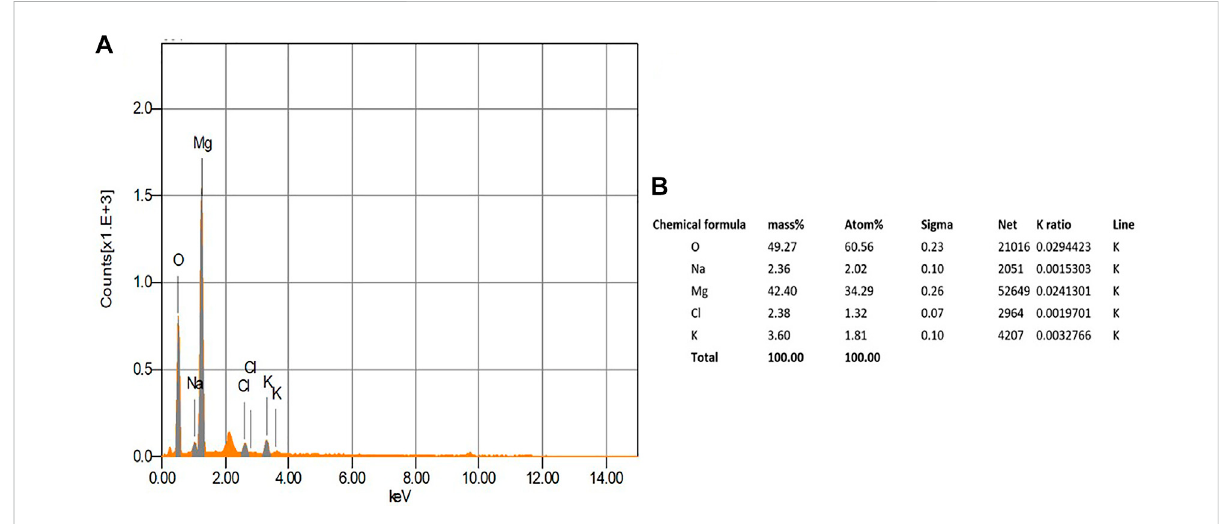
FIGURE 6 EDX analysis of the biogenic